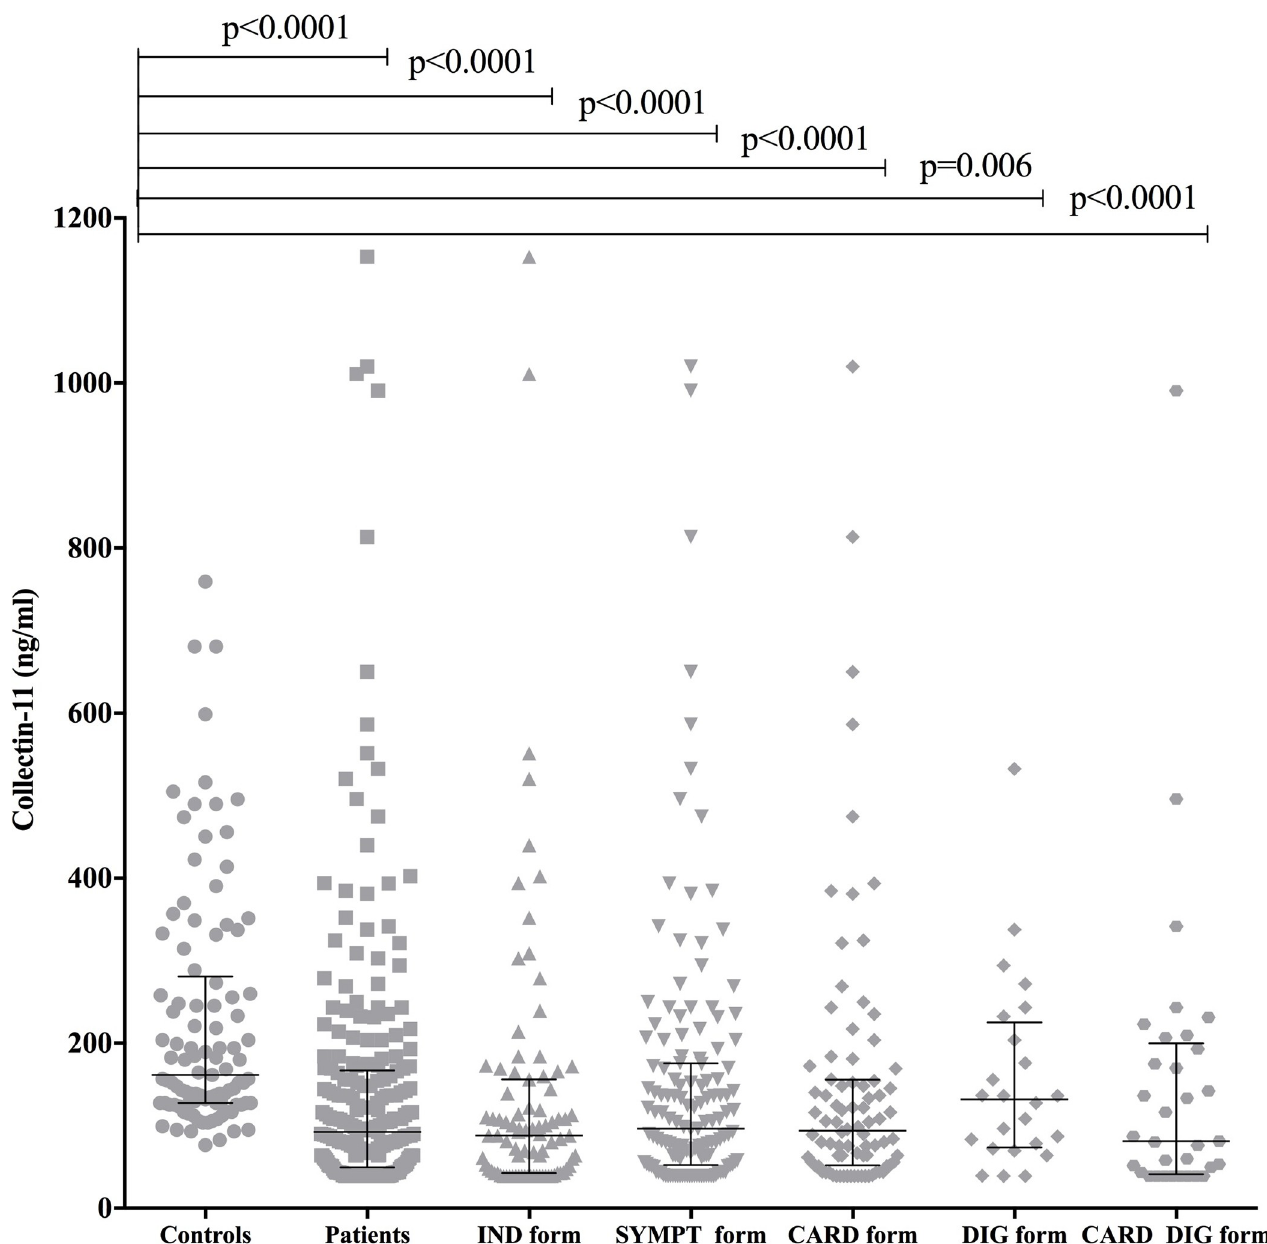
Fig 2. Collectin-11 plasma levels in patients with chronic CD and healthy controls collectin-11 plasma levels are divided in groups: Healthy controls (controls, n = 102), all patients independent of clinical form (patients, n = 234), asymptomatic patients (IND form, n = 87), symptomatic patients (SYMPT form, n = 143), patients with cardiac form (CARD form, n = 85), patients presenting digestive form (DIG form, n = 25) and patients with cardiodigestive form (CARD_DIG form, n =